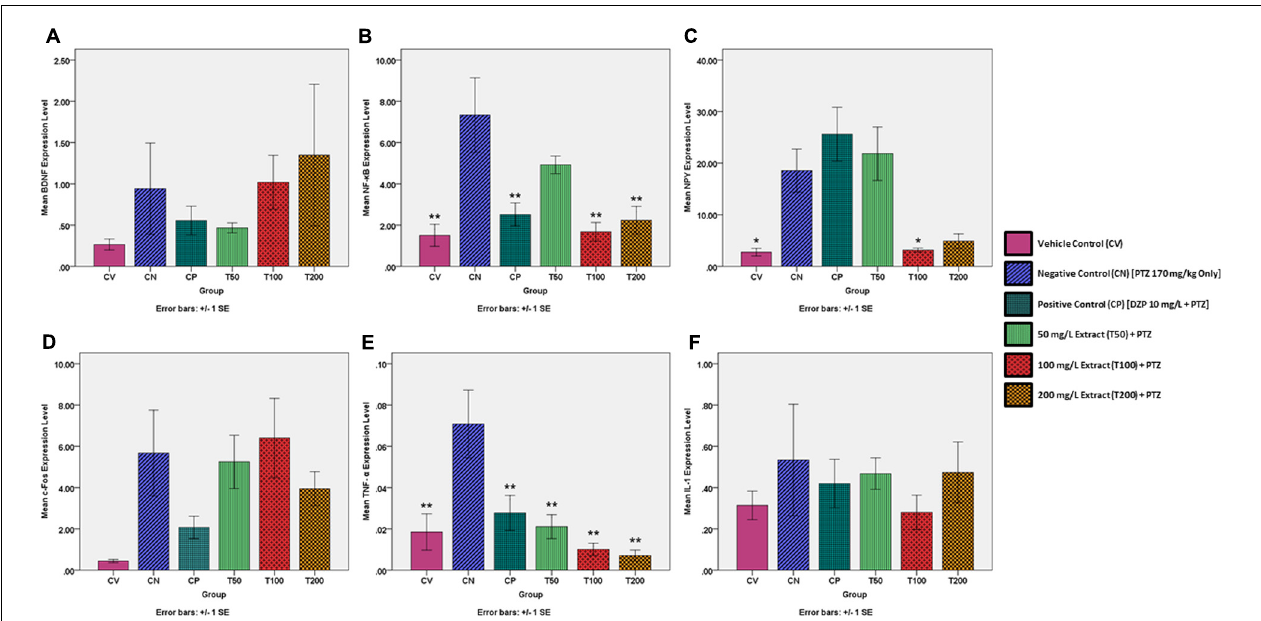
FIGURE 3 | Expression levels of several genes in the brains of each experimental group as determined by real time-PCR. All changes in expression levels were as compared to the negative control group (CN, 170 mg/kg PTZ Only), and included the genes: (A) BDNF (B) NF- κ B (C) NPY (D) c-Fos (E) TNF- α and (F) IL-1. The data is expressed as Mean ± SEM, n = 6 and was analyzed using one-way ANOVA, followed with Dunnett’s test at significance level of ∗∗ P < 0.01 and ∗ P <